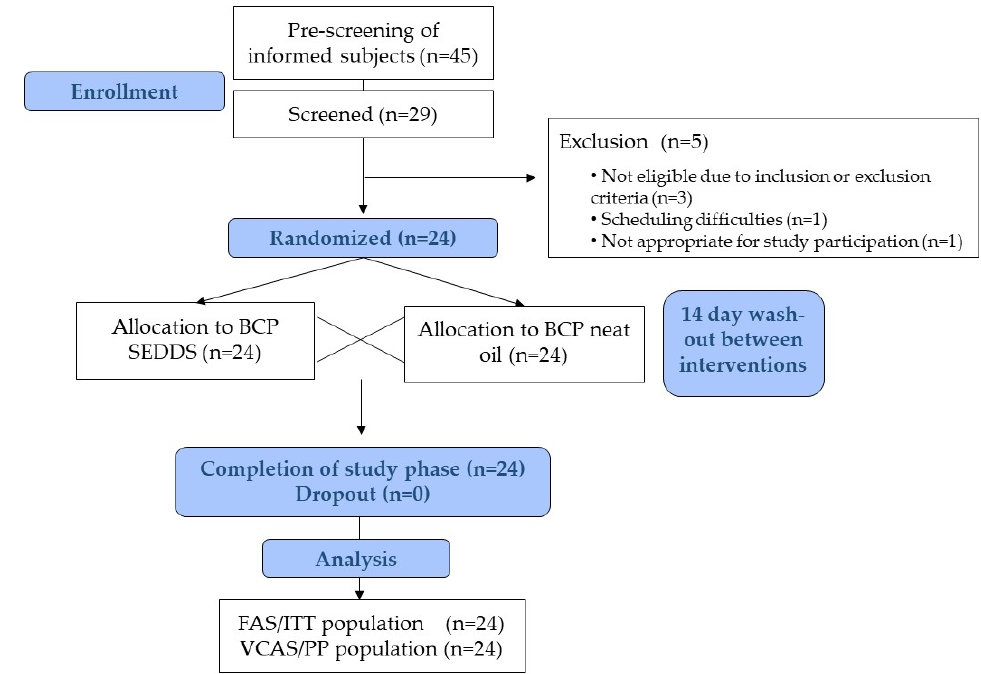
Figure 3. Study flow chart and subject disposition.